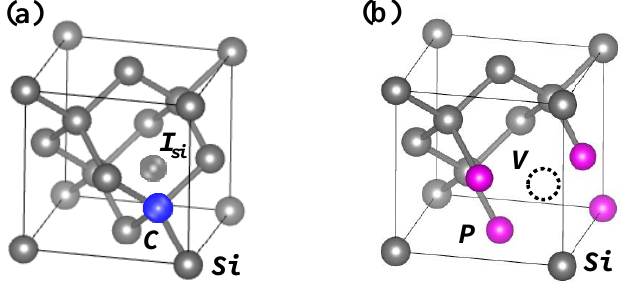
Figure 14. Schematics of ( a ) C–I and ( b ) P 4 –V complex formed in CH 2 P-molecular-ion-implanted region after epitaxial growth. The carbon and phosphorus are blue and pink, respectively.